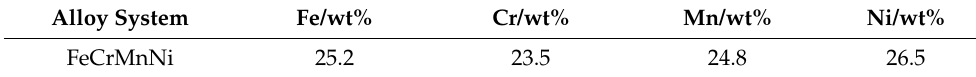
Table 1. Elemental ratios for each system of high entropy alloys. Alloy